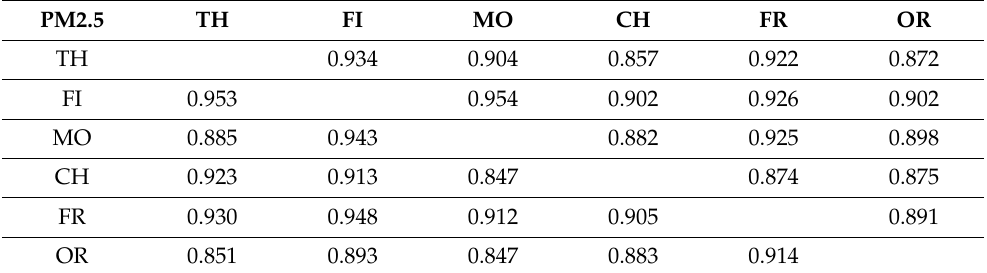
Table 5. Pearson linear correlation coefficient matrix for PM2.5 (summer semester above the diagonal, winter semester below), for the six stations of the coastal strip.